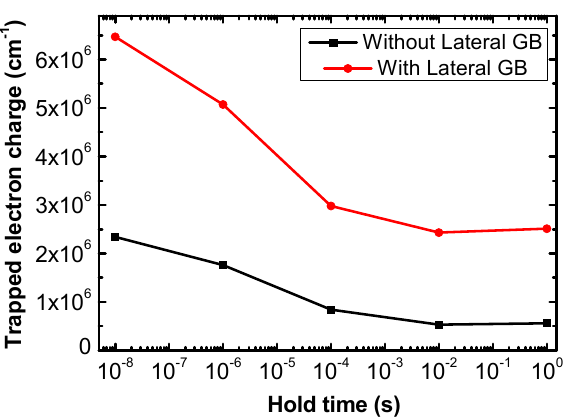
Figure 12. The change of the trapped electron charge of Vertical_Center without and with lateral GB according to the hold time during the Read “0” operation.